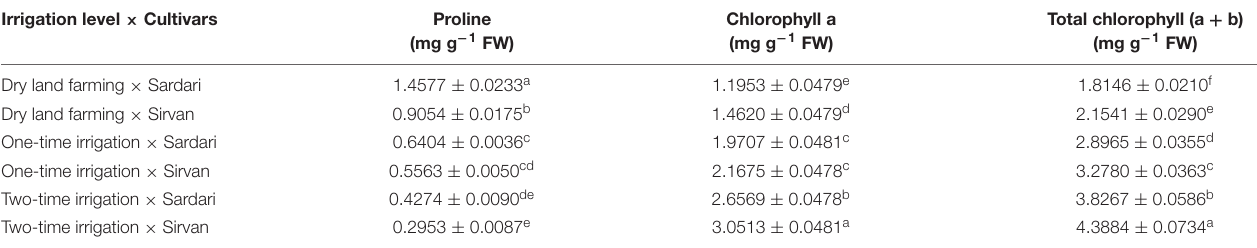
TABLE 7 | Comparison of the mean of the dual interaction of cultivar and irrigation on some studied traits of wheat in 2017–2018. Irrigation level × Cultivars